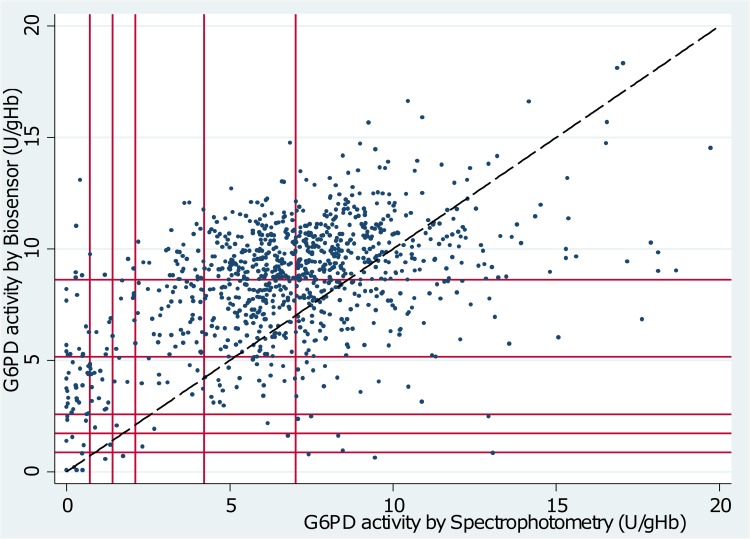
Scatter plot of G6PD activity measured by Spectrophotometry vs. Biosensor.Diagonal line = line of equality. Starting from origin outwards vertical and horizontal lines mark 10%, 20%, 30%, 60% and 100% activity of the adjusted male median based on spectrophotometry and Biosensor respectively.